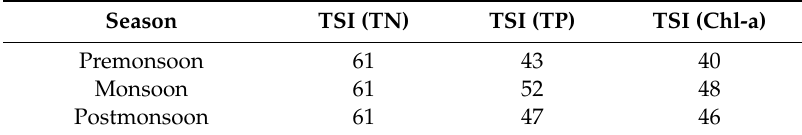
Trophic state index (TSI) during pre-monsoon, monsoon, and post-monsoon in the Soyang